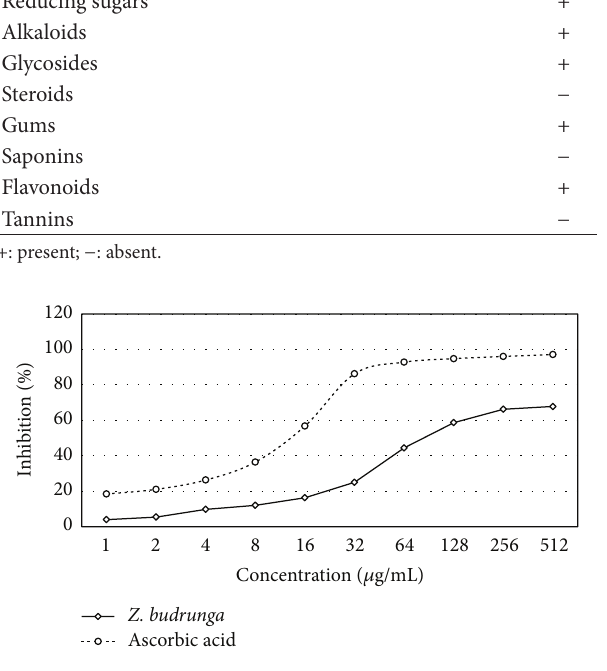
Figure 1: DPPH scavenging activity of Z. budrunga seed